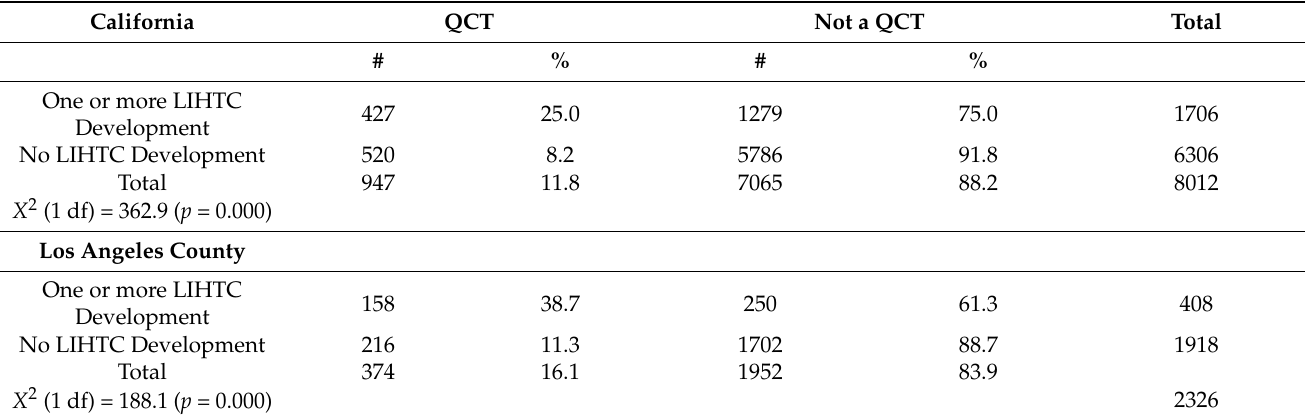
Table 3. LIHTC Neighborhoods and QCTs, CA and LA County.